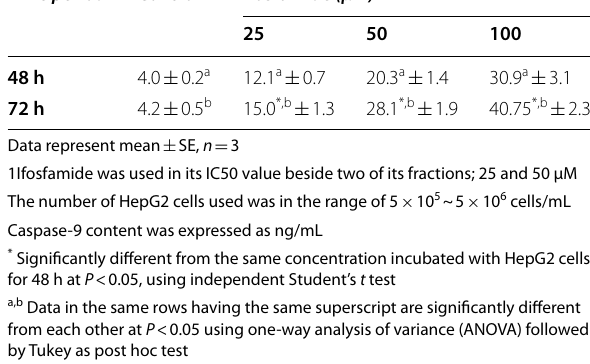
Table 5 Effects of ifosfamide on caspase-9 content in cell lysate of cultured HepG2 cells